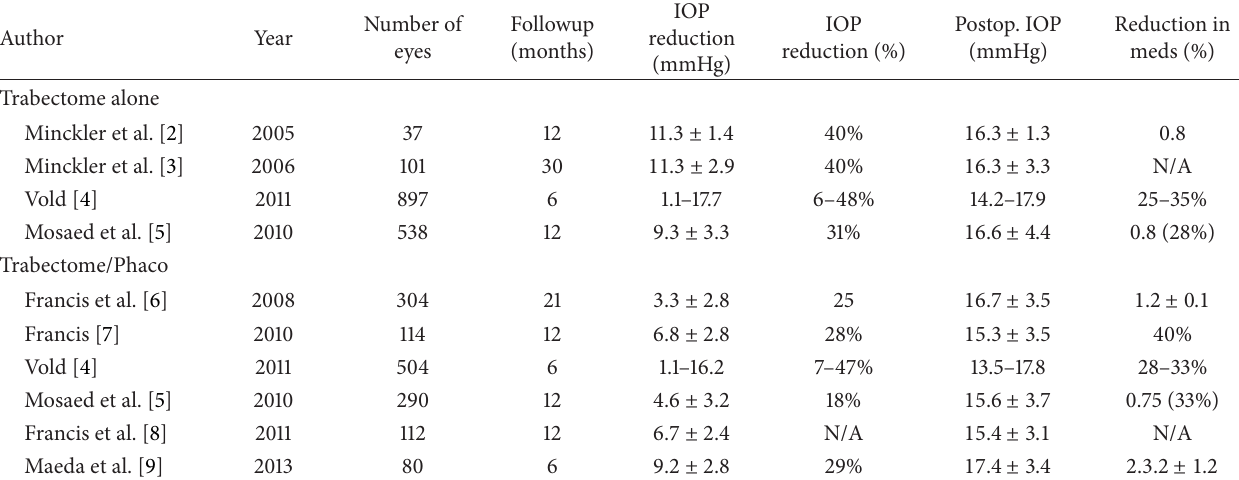
Table 3: Trabectome studies results.